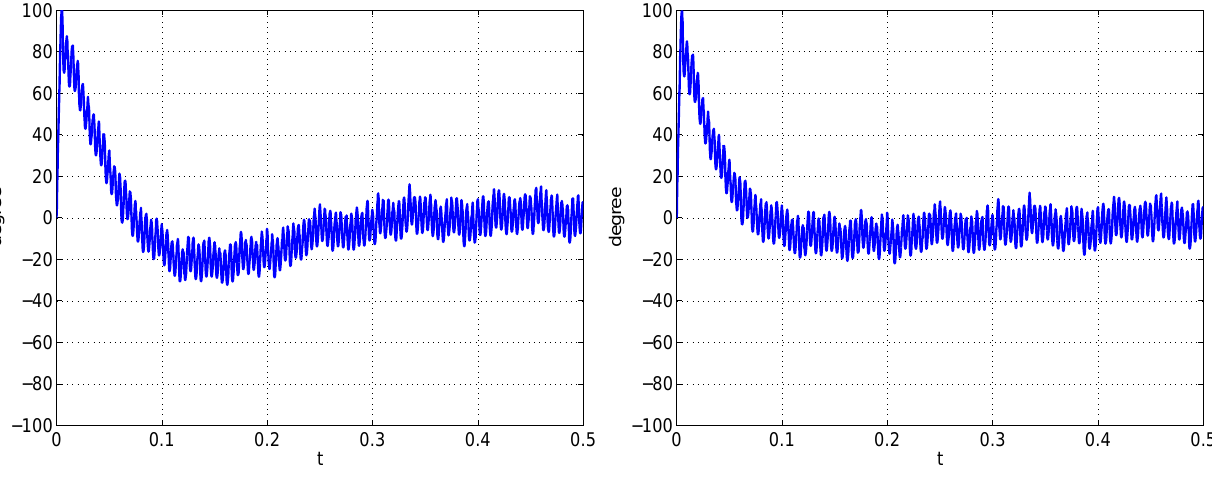
Figure 12. Real GPS experimental results. Left : linear design. Right : nonlinear